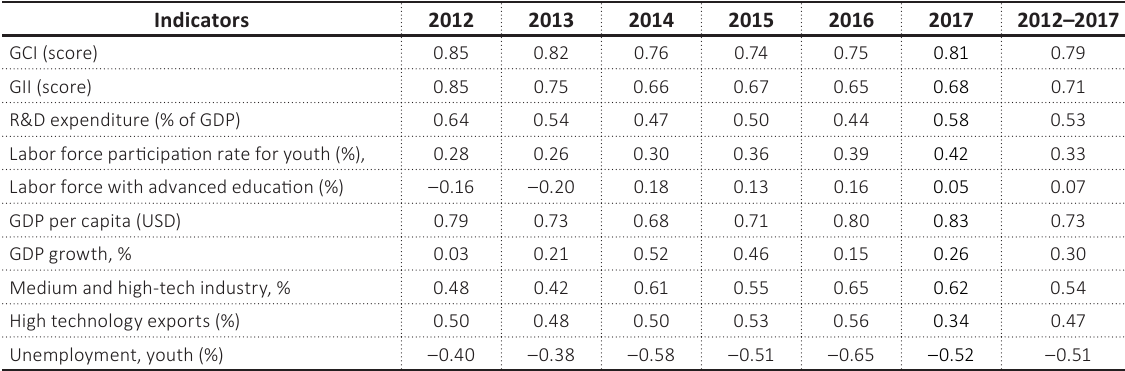
Figure 2. Correlation between the level of competitiveness of U21 higher education systems and socio-economic development indicators Table 6. Correlation indices between the quality index of higher education (GCI component) and selected indicators of economic